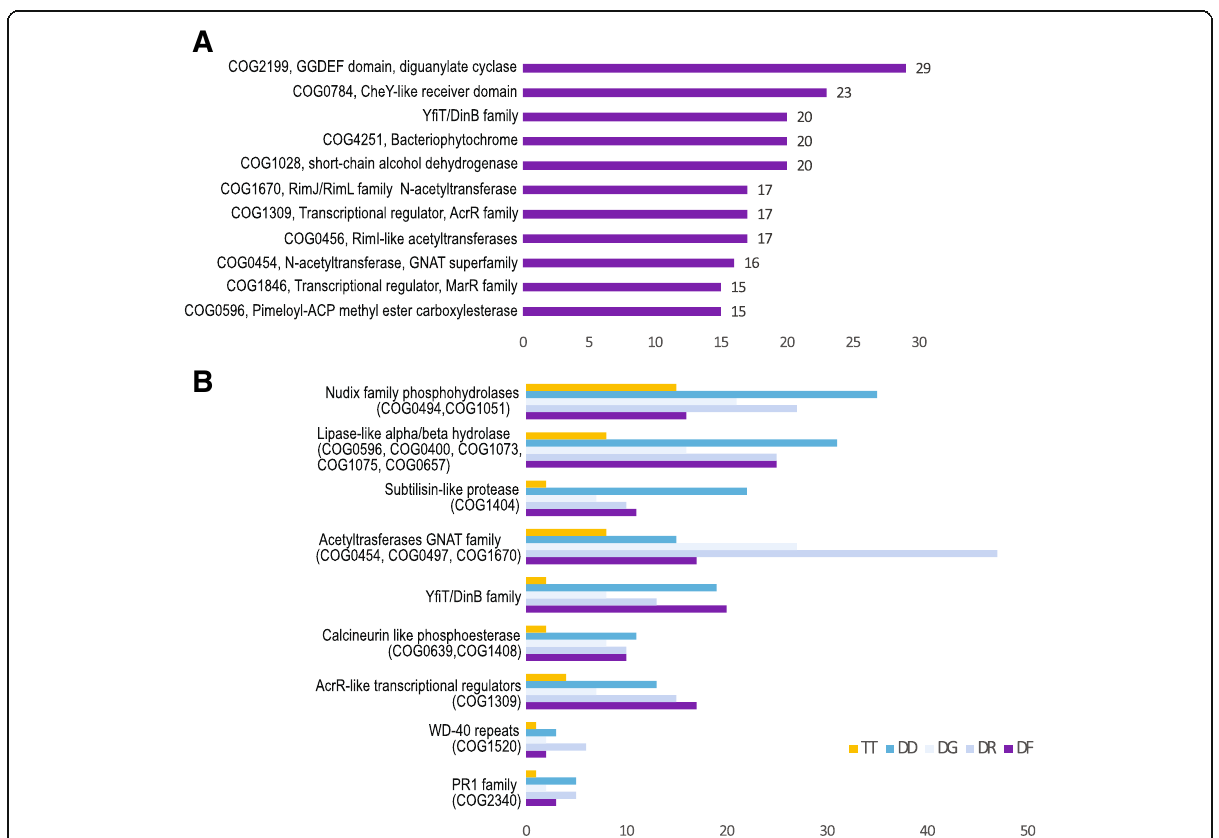
Fig. 4 Expanded protein families in D. ficus KS 0460. a Protein families with 15 or more paralogs in D. ficus genome. COG number and family name are indicated on the left . b Comparison of protein families found to be specifically expanded in Deinococcus species. Numbers of proteins correspond to a sum of all COG members indicated in parenthesis on the left . Abbreviations: DF, D. ficus KS 0460; DR, D. radiodurans BAA-816; DG, D. geothermalis DSM 11300; DD, D. deserti VCD115; TT, Thermus thermophiles HB27. Results for DinB/YfiT family were identified using COG2318 and